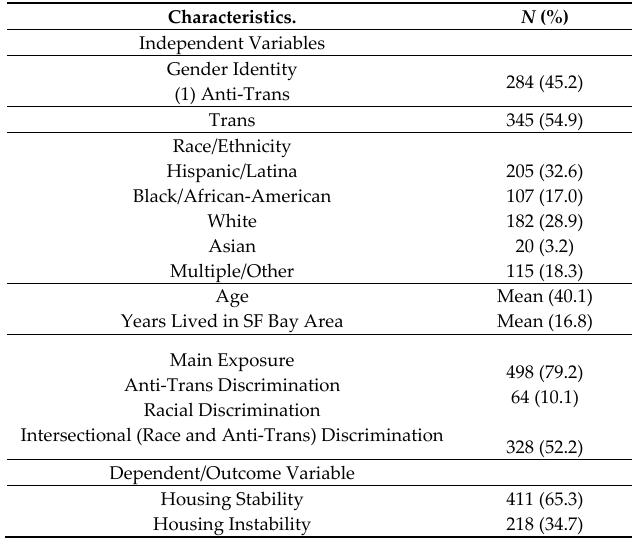
Table 1. Demographic characteristics and experiences of anti-trans, racial and intersectional racial and anti-trans discrimination by trans women in the San Francisco Bay Area, 2016–2018. Characteristics.